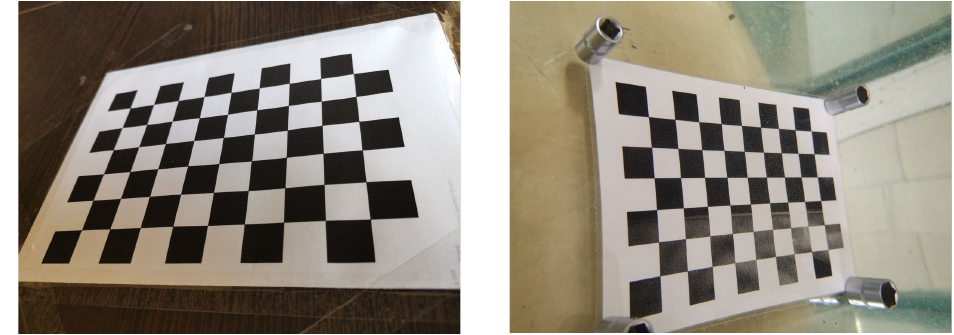
Figure 1. Examples of images made with the same camera in the air ( left ) and underwater ( right